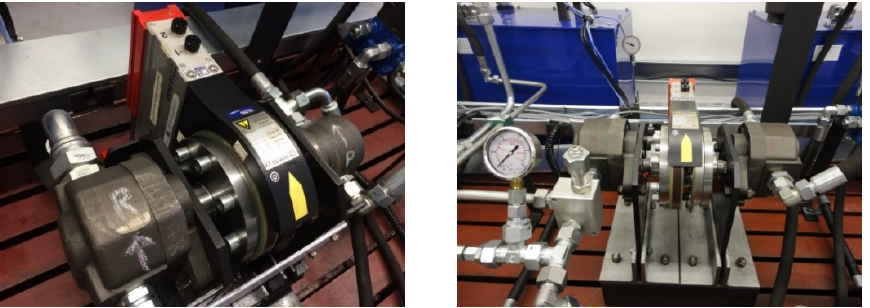
Figure 3. Connection of hydraulic motor and hydraulic pump with combined speed rotation and torque sensor.